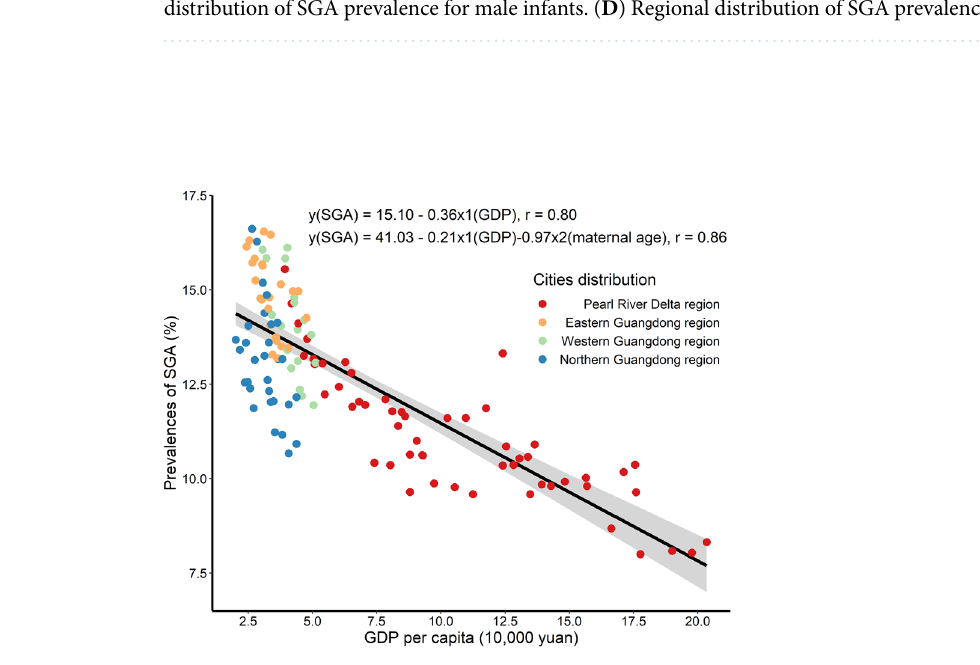
Figure 4. The correlation between SGA and per-capita GDP, China from 2014 to 2019. The Pearl River Delta, Eastern, Western, and Northern Guangdong, which are marked in red, orange, green, blue,